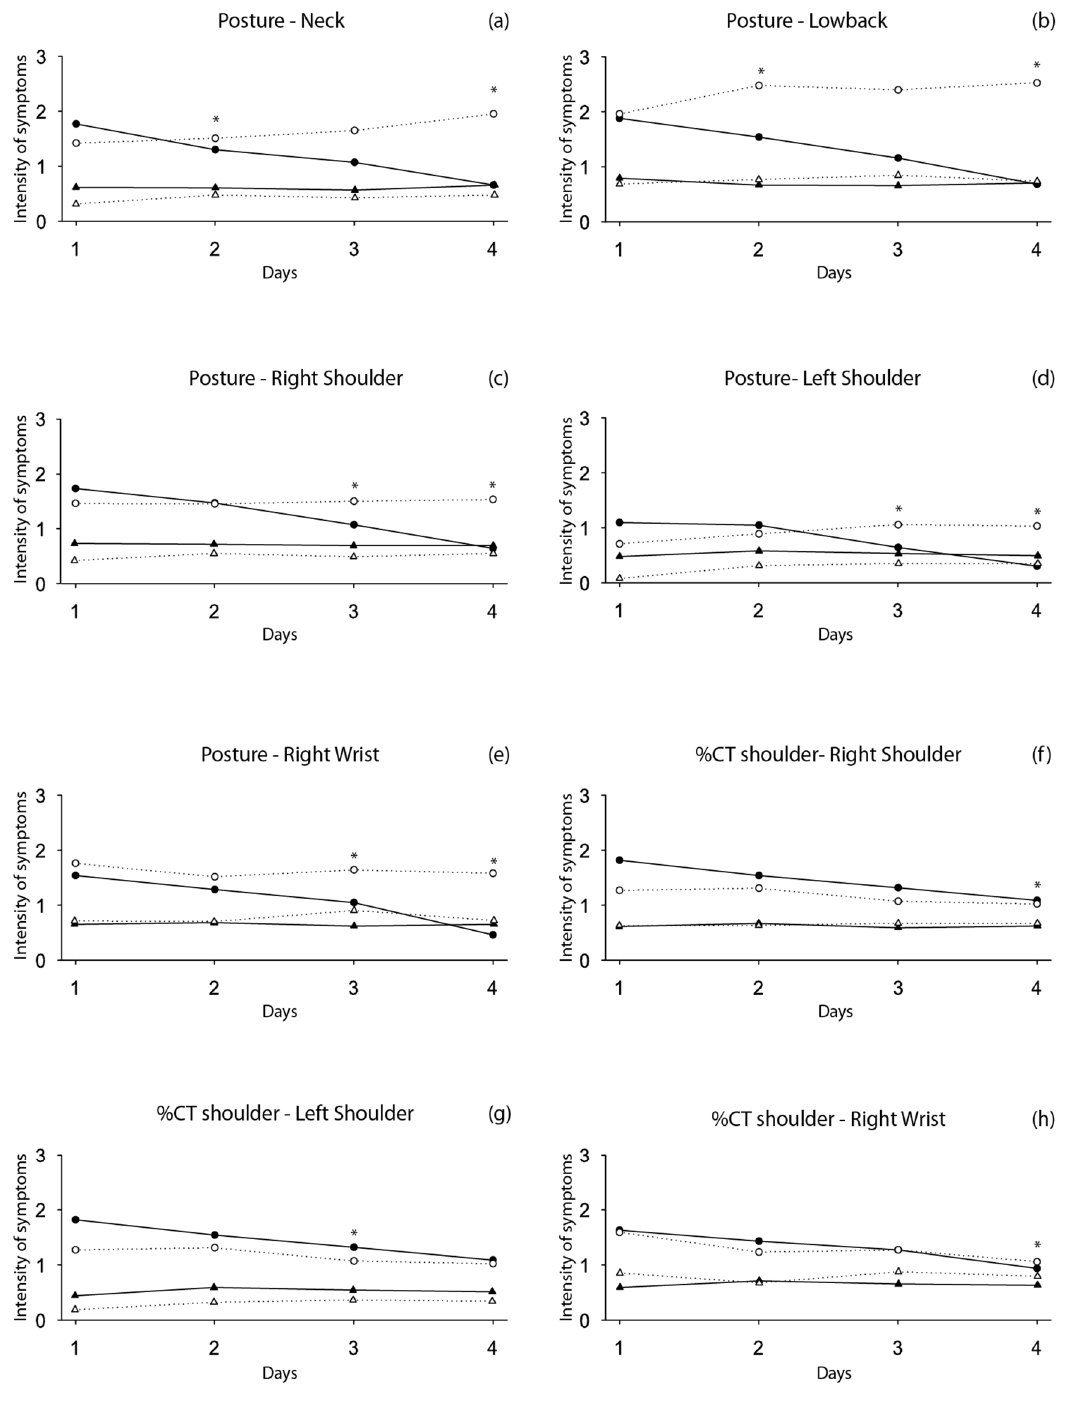
force and right wrist; ( e ) within-group changes are shown for %CT bent and neck; ( f ) within-group changes are shown for %CT bent and right shoulder; ( g ) within-group changes are shown for %CT bent and left shoulder; ( h ) within-group changes are shown for %CT bent and right wrist. * Within-group changes for the afternoon group significant at p < 0.05.